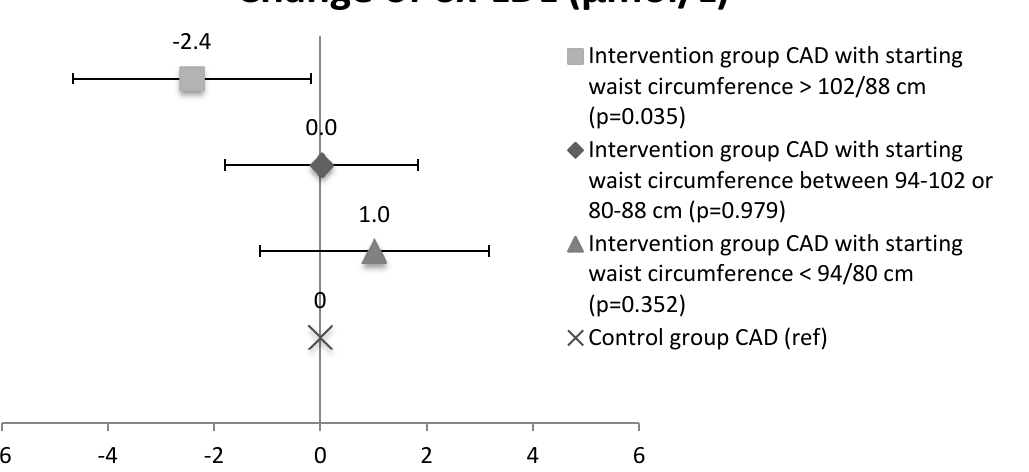
Figure 4. Change of oxidized LDL lipids in CAD waist-circumference subgroups. Mean and CI.